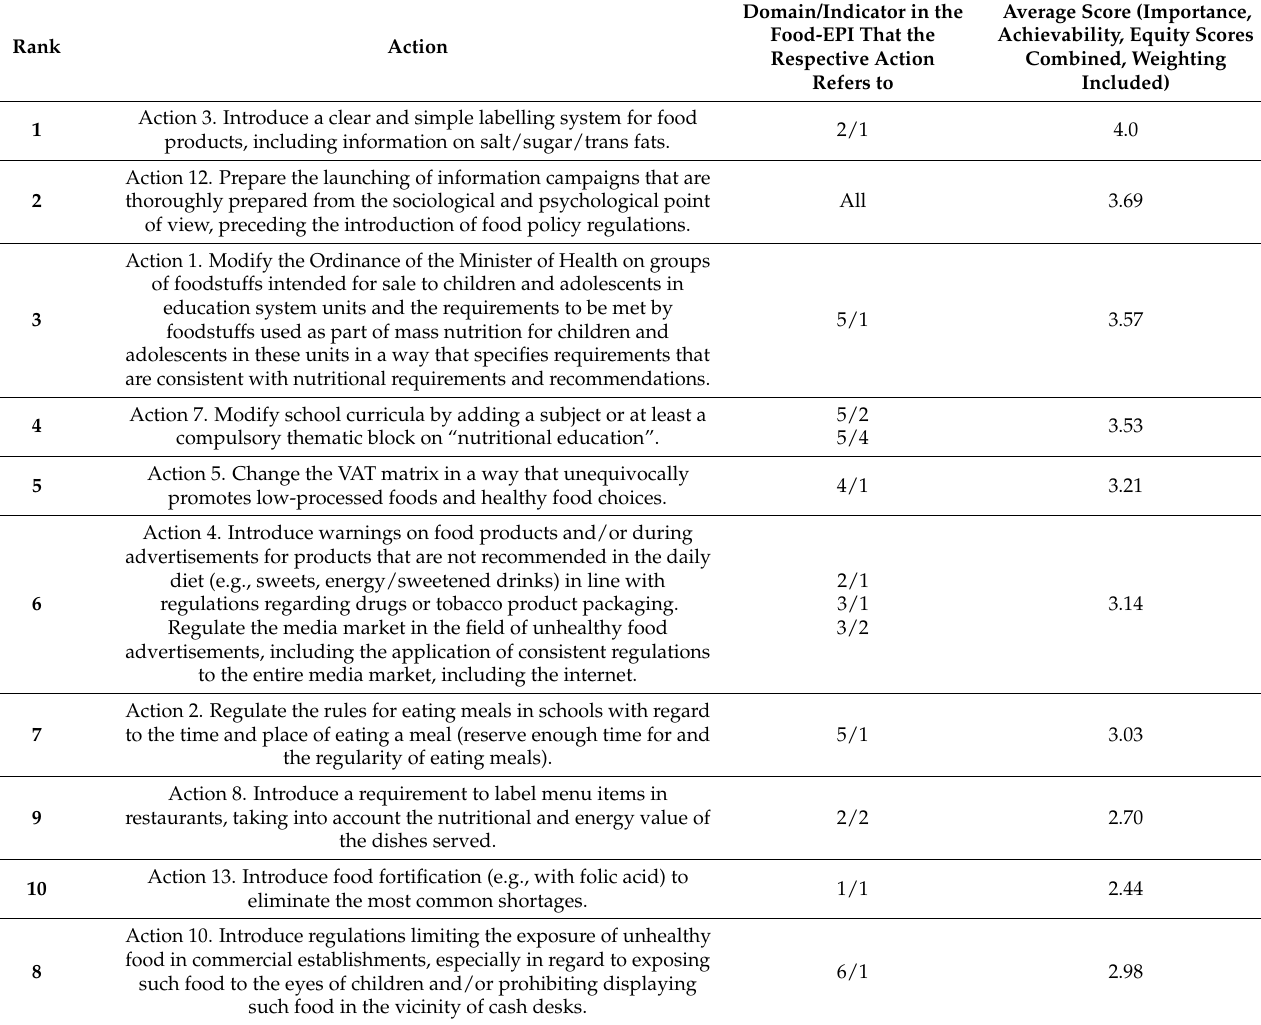
Table 1. Policy-related actions recommended for improving the Polish healthy food environment, ranked by priority. The action labels (action 1, action 2, . . . ) are taken from the original document sent for prioritisation to